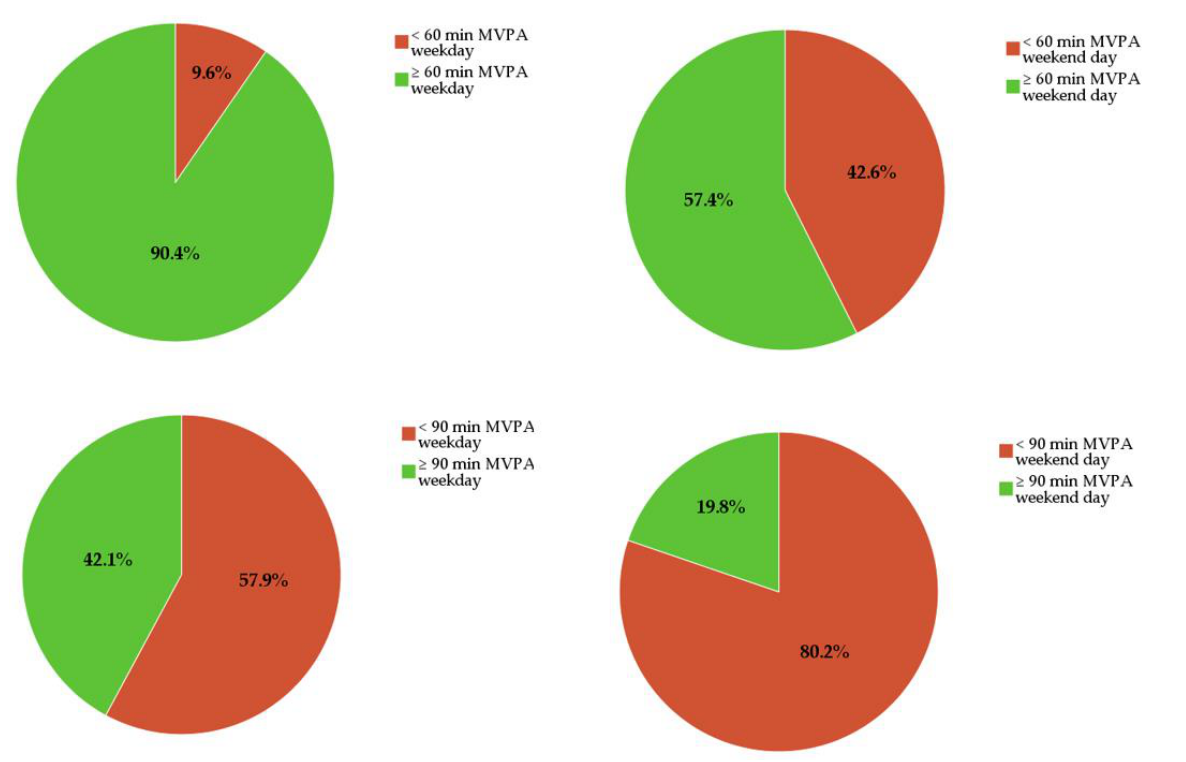
Figure 1. Percentages of the sample fulfilling the respective PA recommendations. Green = recommendation fulfilled, red = recommendation not fulfilled; MVPA = moderate-to-vigorous physical activity. Table 1. Sedentary and physical activity behavior in minutes and in percent of wear time (mean (SD)) on average weekdays, weekend days and in total (N = 425).